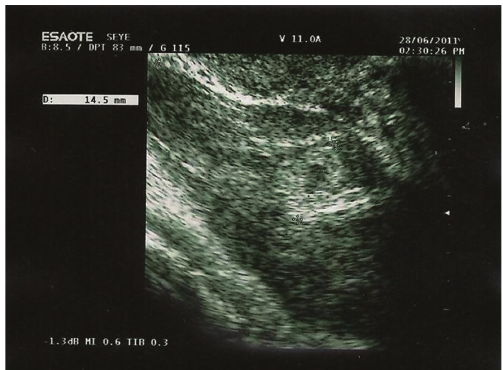
Figure 2: Transvaginal ultrasound of uterus showing left ovaric mass containing ovular